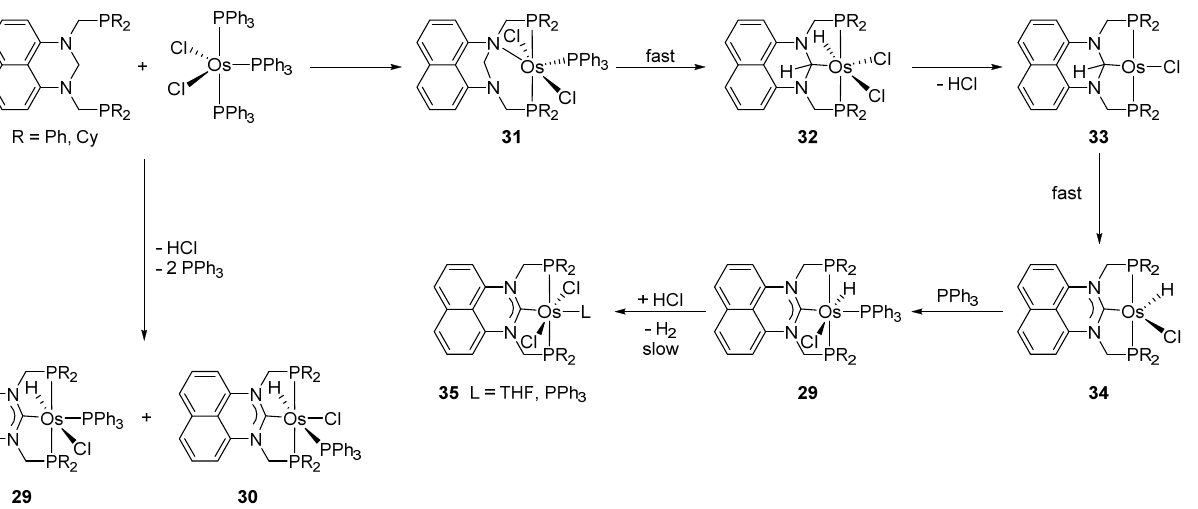
Figure 7. Synthesis of P~C~P pincer complexes by cleavage of a C-C bond. The N,N ’-bis(phosphinomethyl)dihydropermidine-type ligands H 2 C(NCH 2 PR 2 ) 2 C 10 H 6 (R = Cy, Ph) react with [OsCl 2 (PPh 3 ) 3 ] yielding the P~C~P pincer